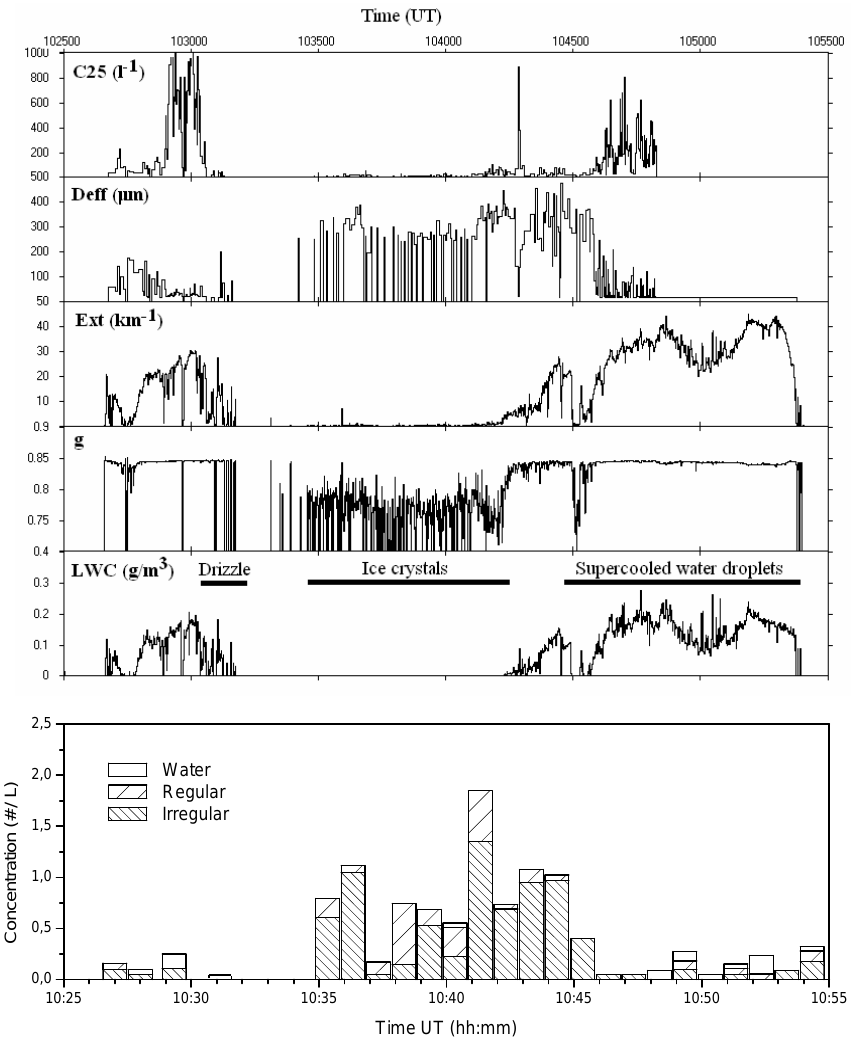
Fig. 3. Time-series of microphysical and optical parameters measured at 1400m/ − 11 ◦ C level. C25: particle concentration of particles with D > 25 µ m, Deff: effective diameter, Ext: extinction coefficient, g: asymmetry parameter and LWC : liquid water content. The shape classification of particles larger than 50 µ m from CPI images is also reported with three categories, i.e. water spherical droplets, regular shape (columns, plates, ...) and irregular shape